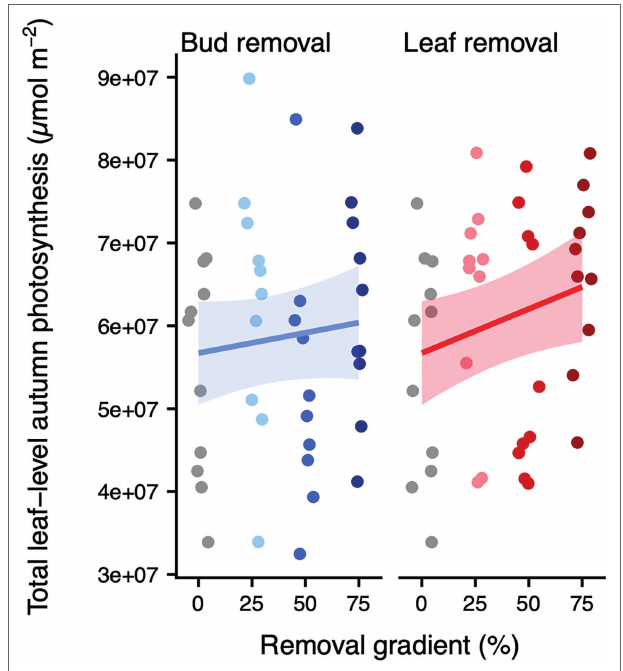
FIGURE 2 | Total leaf-level autumn photosynthesis ( μ mol m − 2 ) across the bud (left panel) or leaf removal gradient (right panel). The colors correspond to the different treatments. For each organ removal, we only display the treatments that have 0% of the other organ removed (i.e., the leaf removal panel does only include treatments where bud removal = 0). We added (back transformed) predicted means and approximate 95% confidence intervals for the model of total leaf-level autumn photosynthesis. Model results are listed in Supplementary Table 4 . Model diagnostics are displayed in Supplementary Figure 5